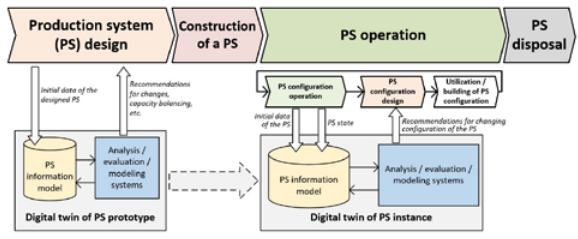
Fig. 1. Building a digital twin of a production system at various stages of its life cycle